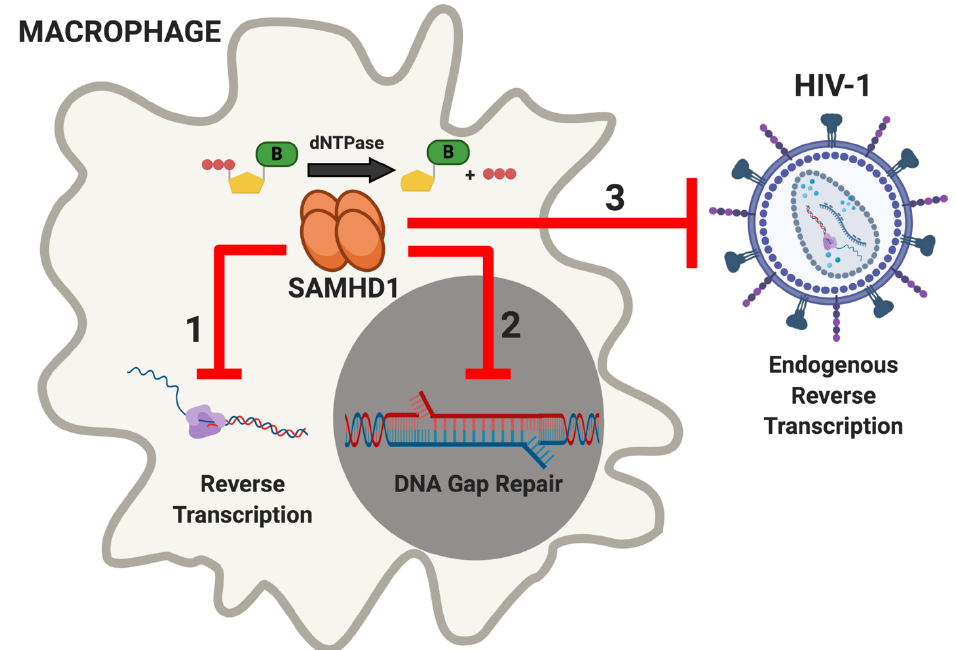
Figure 3. Host SAMHD1 restricts HIV-1 infection within macrophages at the reverse transcription, integration, and ERT steps of viral replication. Tetrameric SAMHD1 (orange), which can reside in the cytosol (beige) and nucleus (dark grey), restricts the HIV-1 lifecycle at three points during viral infection of a macrophage. The SAMHD1-mediated low dNTP pools in macrophages inhibit reverse transcription in the cytosol (red inhibition arrow 1), gap repair within the nucleus (red inhibition arrow 2), and ERT activity occurring extracellularly (red inhibition arrow 3).